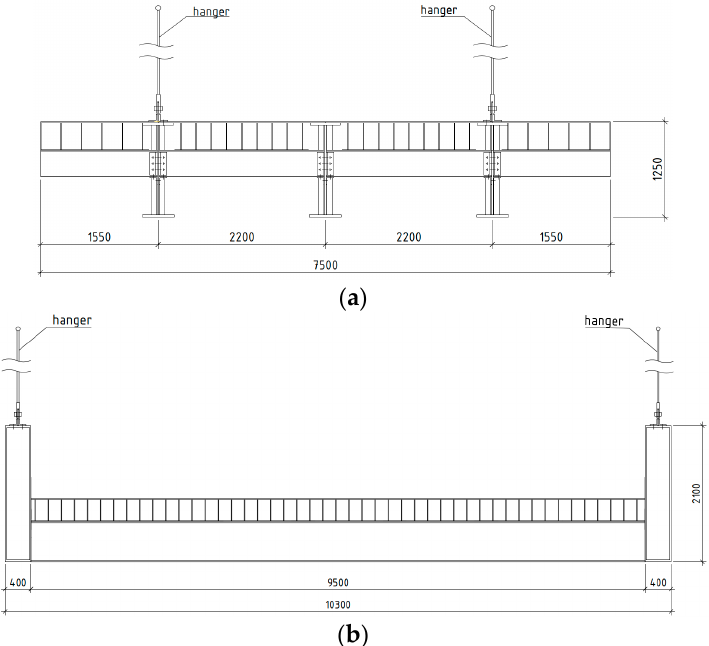
Figure 2. Different types of the cross-sections of the superstructure (girders): The first girder cross- sections with a passage on the top ( a ) and the second girder cross-sections with a passage on the bottom ( b ).